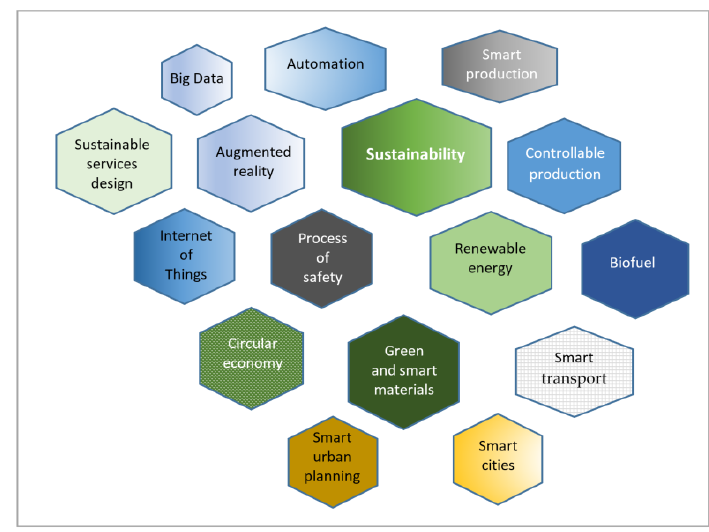
Figure 13. Cluster of current areas of interest for scientists in the field of sustainable Industry 4.0. Source: Own study based on bibliometric analysis.